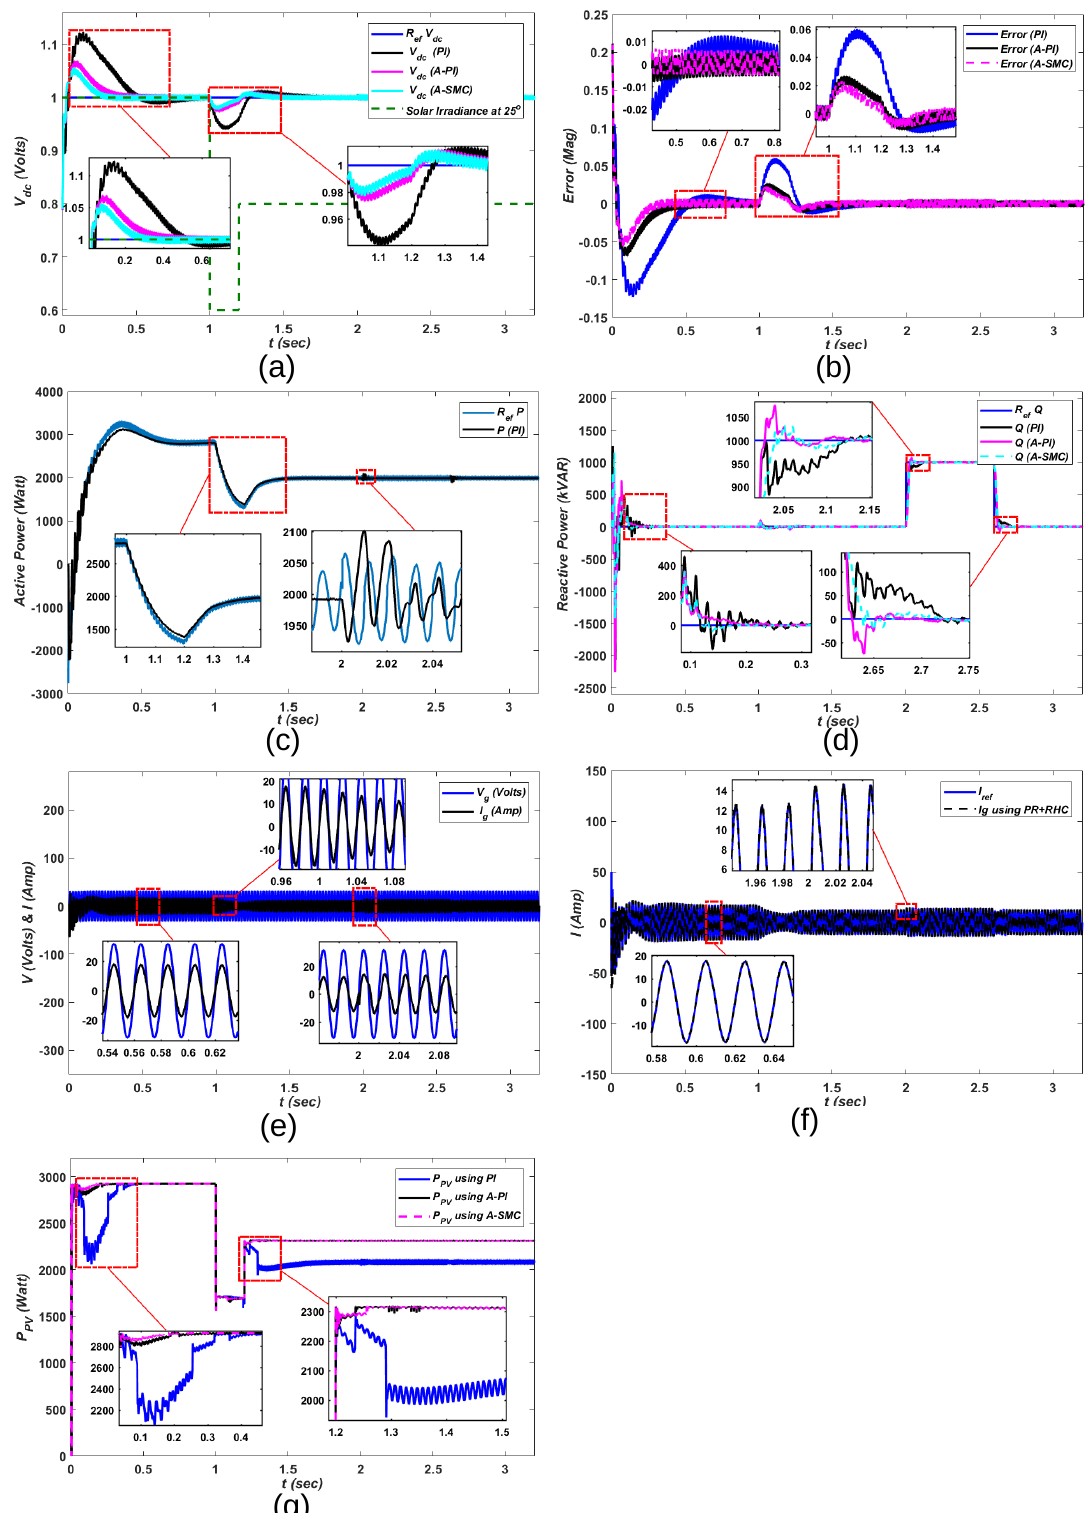
Figure 6. ( a ) The performance of DC-link voltage tested for the designed controllers; ( b ). Error response for PI, A-PI, and A-SMC. ( c ) Active power loop response for the PI controller. ( d ) Reactive power injection for the designed controllers. ( e ) Grid voltage and current. ( f ) Grid currents using PR and RHC. ( g ) Power of the PV panel for the designed